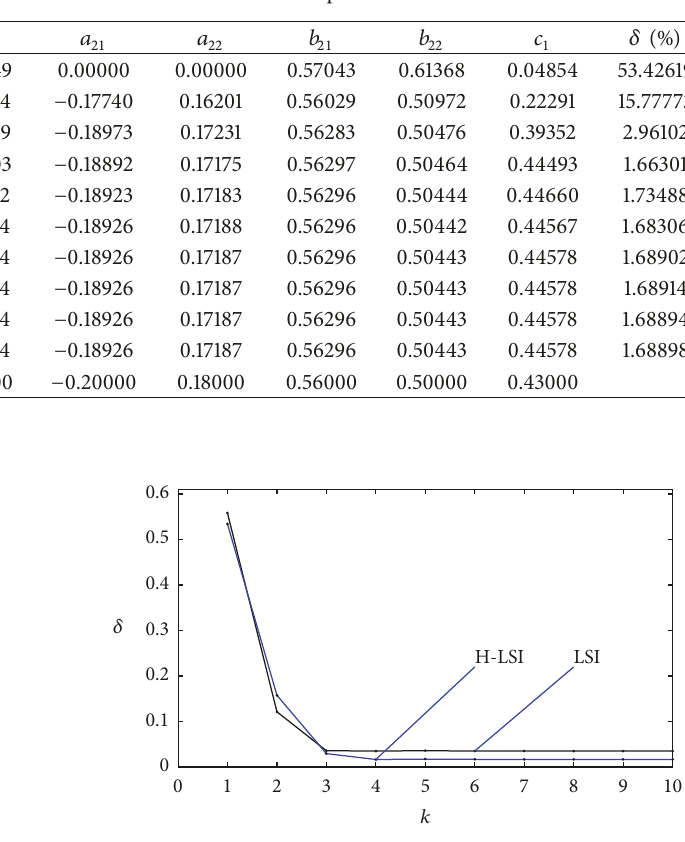
Figure 1: The GI estimation errors 𝛿 versus 𝑘 with different 𝜎 2